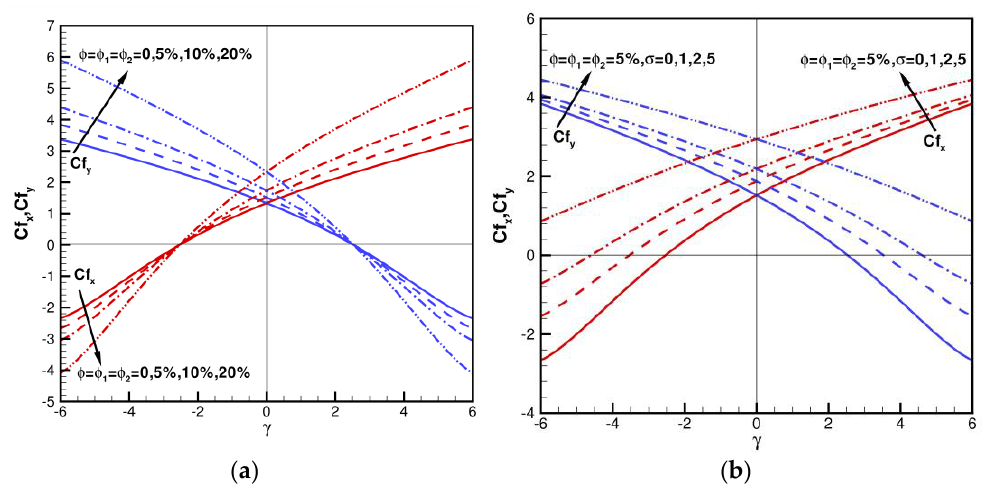
Nu against γ in the range of 86 −  for various σ = 0, 1, 2 are 5%, and Pr = 6.2, x N u increase. When γ < 0, val- , ,  increase, the values of shown in Figure 5b. As x 2 1 N u decrease and change clearly with σ increasing. When γ > 0, values of N u ues of Figure 5. The skin friction coefficients of yx CfCf , for various γ ,  , and σ when Pr = 6.2. ( a ) Im- Figure 5. The skin friction coefficients of Cf x , Cf y for various γ , φ , and σ when Pr = 6.2. ( a ) Impact of x x are less affected by the values of σ . pact of σ = 0, 21  == = 0, 5%, 10%, 20%; ( b ) Impact of 21  == = 5%, σ = 0, 1, 2, 5. σ = 0, φ = φ 1 = φ 2 = 0, 5%, 10%, 20%; ( b ) Impact of φ = φ 1 = φ 2 = 5%, σ = 0, 1, 2, 5. against γ in the 86 −  ,,  increases. When γ < 0, the values of increase 21 ,,  increasing. When γ > 0, the values of Nu in- steeply with volume fractions 21 x ,,  increasing. When  == = 0, crease and slow down with volume fractions 21 21